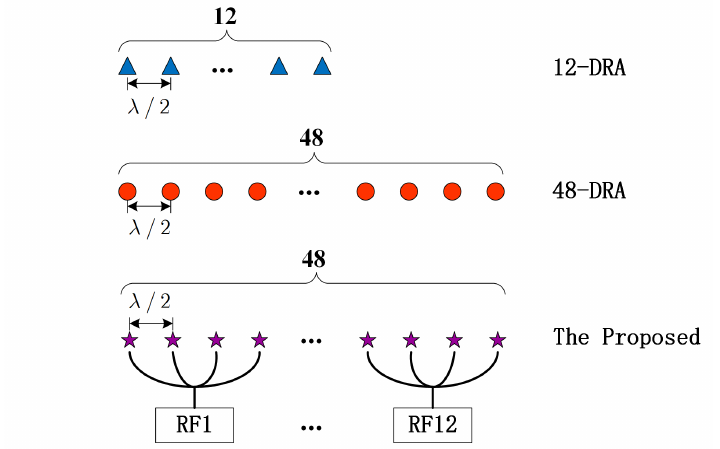
Figure 5. Different DBF systems studied in